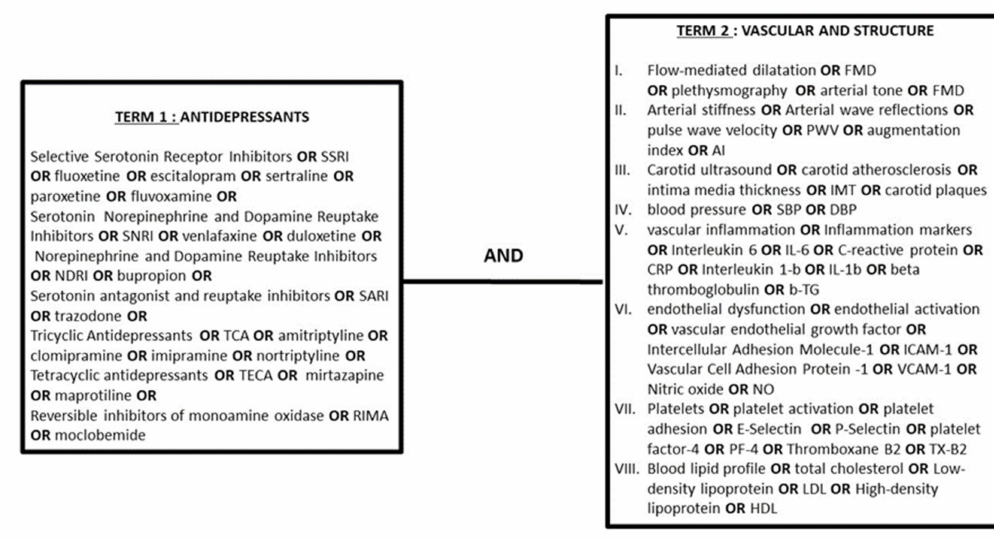
Figure 1. Search strategy depicting the terms and their combinations used in